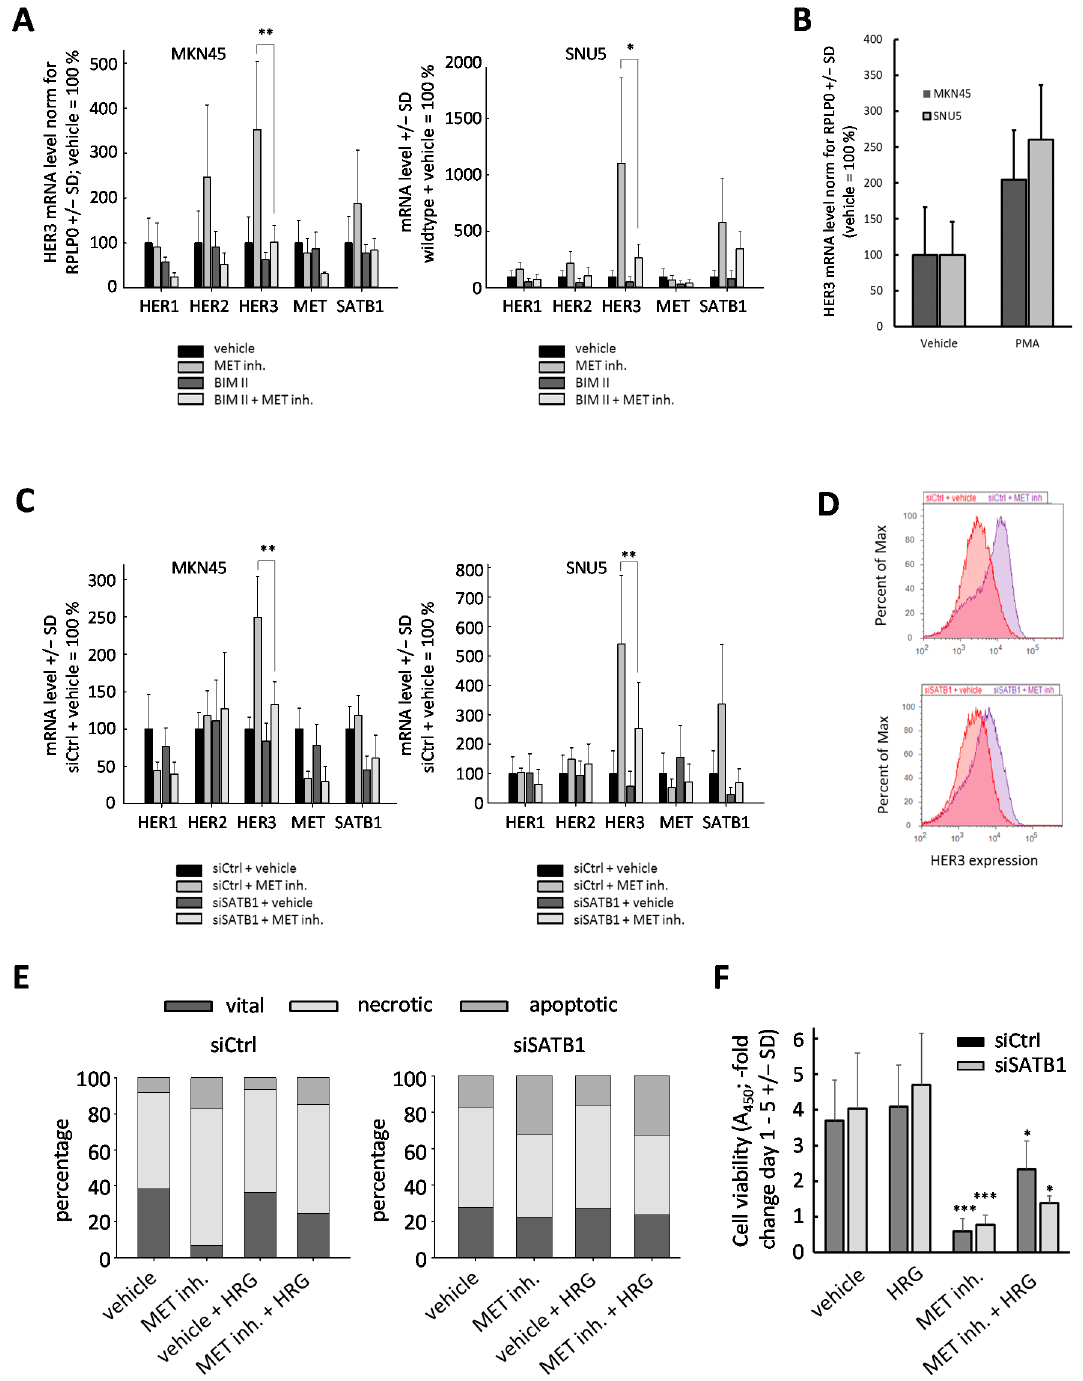
Figure 5. ( A) MKN45 cells (left) and SNU5 cells (right) were pretreated with PKC inhibitor BIM II (10 µM) for 24 h; afterwards, cells were treated with MET inhibitor PF04217903 (0.2 µM for 48 h). ( B ) MKN45 and SNU5 cells were treated for 48 h with the PKC activator PMA (1 µM) before analyzing HER3 mRNA expression. ( C ) MKN45 cells (left) and SNU5 cells (right) were pretreated with SATB1 siRNA for 48 h prior to MET inhibition with 0.2 µM PF04217903 to induce compensatory upregulation effects, as shown previously. siSATB1 significantly reduced the magnitude of observed HER3 mRNA upregulation. ( D ) SNU5 cells also showed diminished HER3 upregulation on the protein level after SATB1 knockdown (48 h after transfection) in comparison with control siRNA. ( E , F ) While siSATB1 showed no antiproliferative effect itself on MKN45 cells, the HRG-associated rescue effect was reduced upon SATB1 knockdown as compared to siCtrl. Level of significance: *, p < 0.05; **, p < 0.01, and ***, p < 0.001.